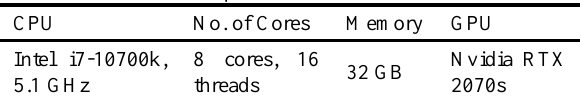
Table. 4. Specification of the test PC